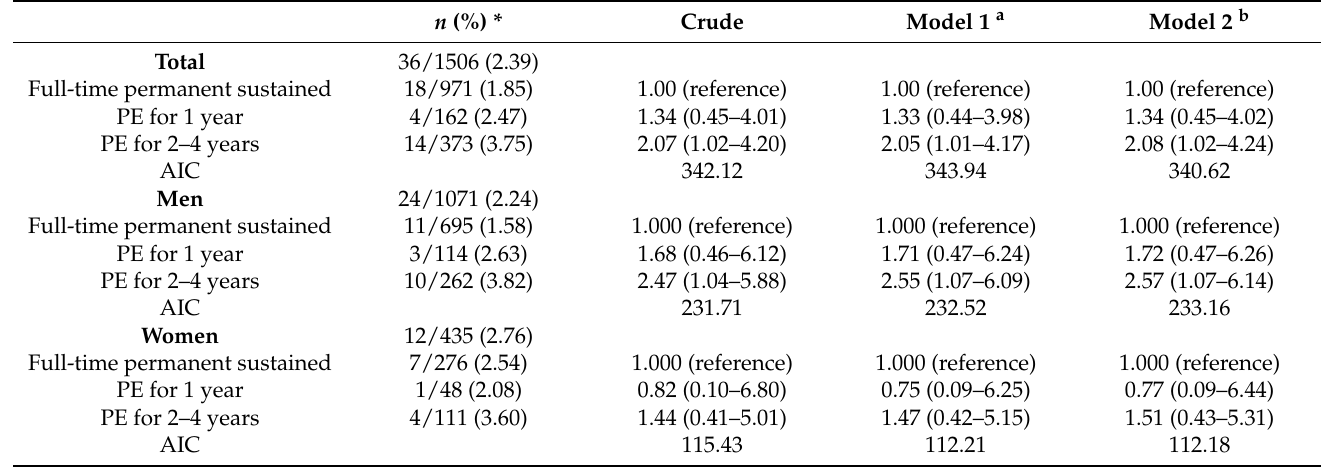
Table 2. Logistic regression models for CAGE as a screen for alcohol-use disorders according to